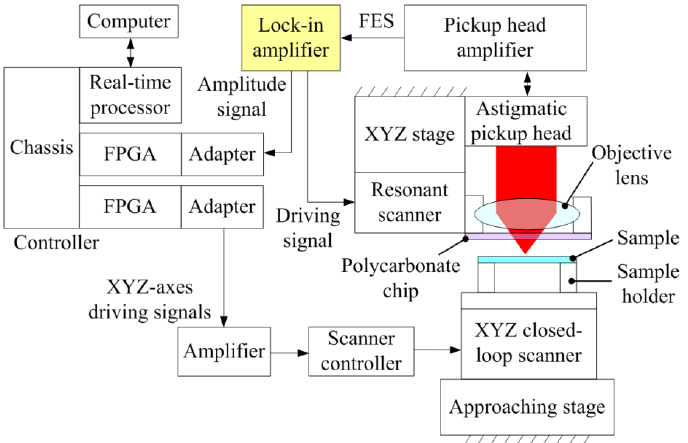
Figure 2. System configuration of an astigmatic optical profilometer for real-time reflectance im- aging.